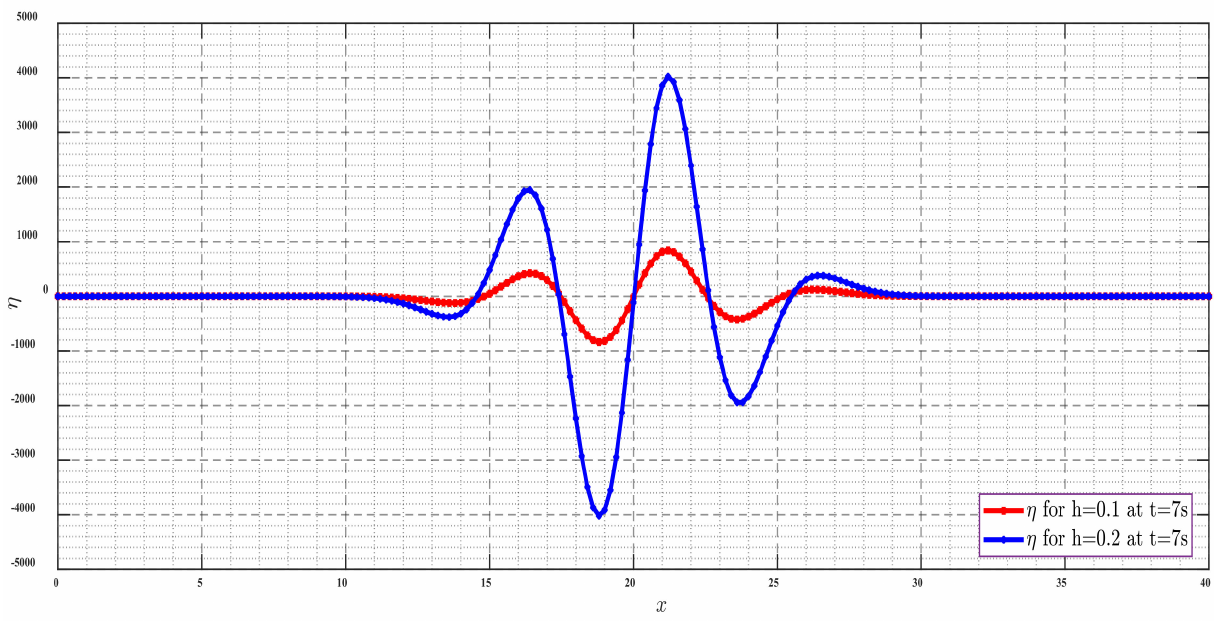
Figure 5. WSE ( η ) of SWWE for h = 0.1 and h = 0.2 at t = 7 s.